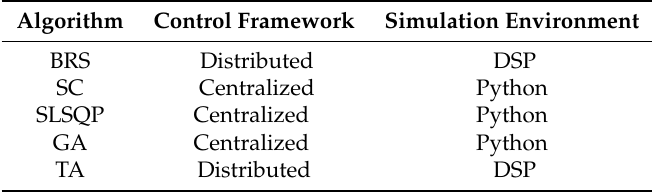
Table 4. The simulation environment for different